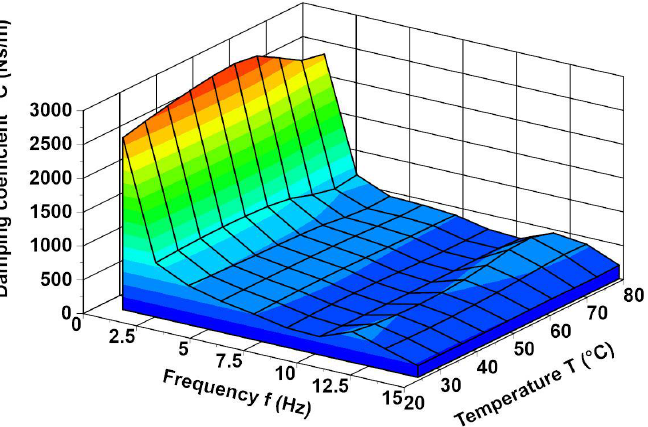
Figure 1. The damping of the spring as a function of frequency for selected temperatures.